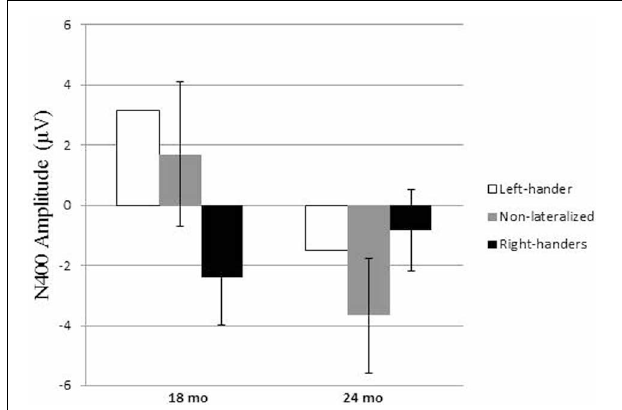
FIGURE 3 | The N400 effect size as a function of age and handedness (The two left-handers are represented here even though, for obvious reason, they were not included in the ANOVA).